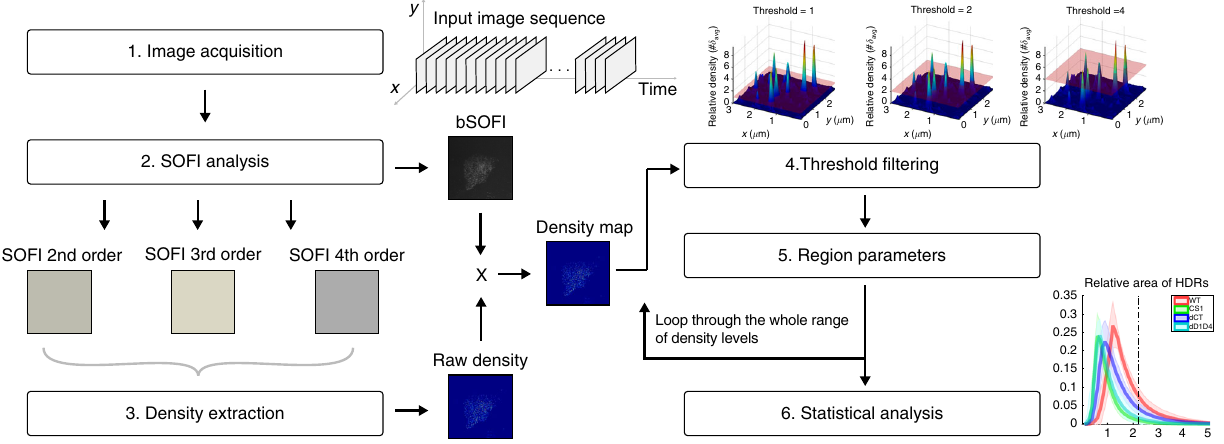
Fig. 1 The work fl ow of SOFI-based molecular density analysis. SOFI images of different cumulant orders were calculated and used to extract molecular densities. The background was removed using the bSOFI image as a transparency mask. High-density regions (HDRs) were segmented by varying the threshold parameter over the whole range of available density levels. For each threshold, the area, equivalent diameter, and number of HDRs were extracted and plotted as a function of the density threshold (Fig. 3). The procedure is then repeated for each sample and